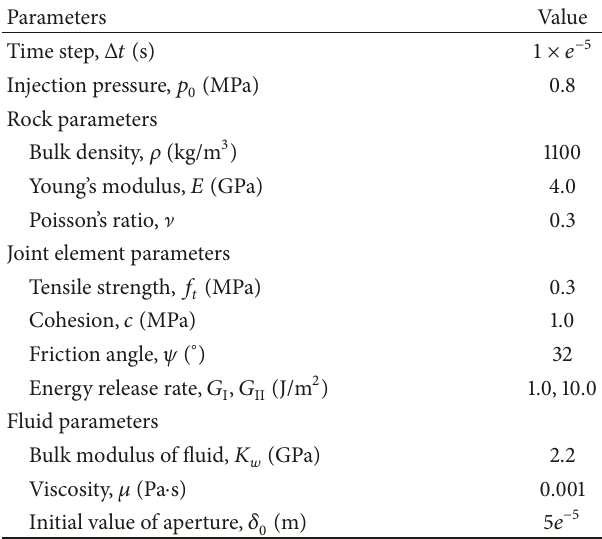
Table 1: Parameters of validation